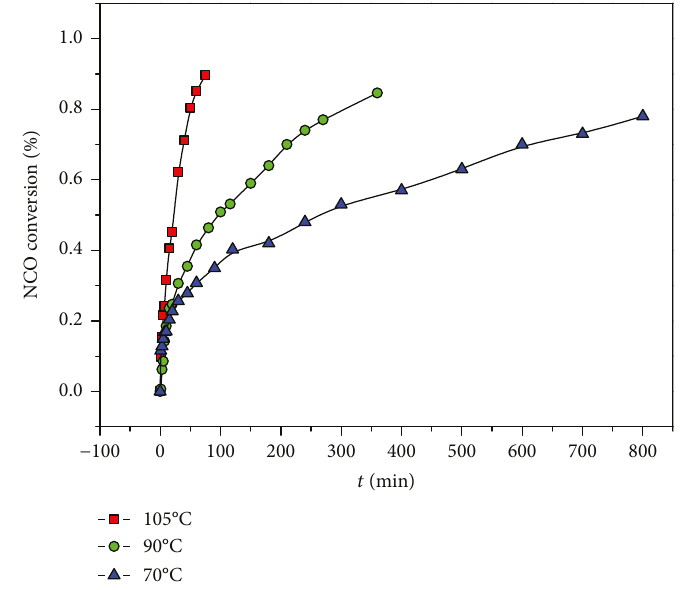
Figure 5: Isocyanate conversion versus curing time of PSU at 75 ° C, 90 ° C, and 105 ° C with 150ppm